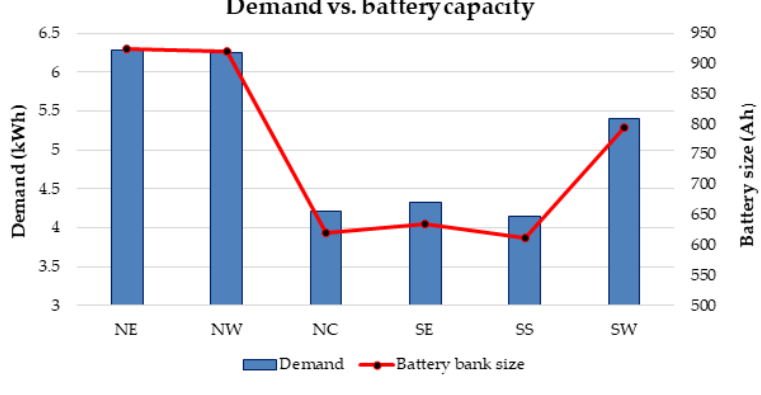
Figure 11. Different battery